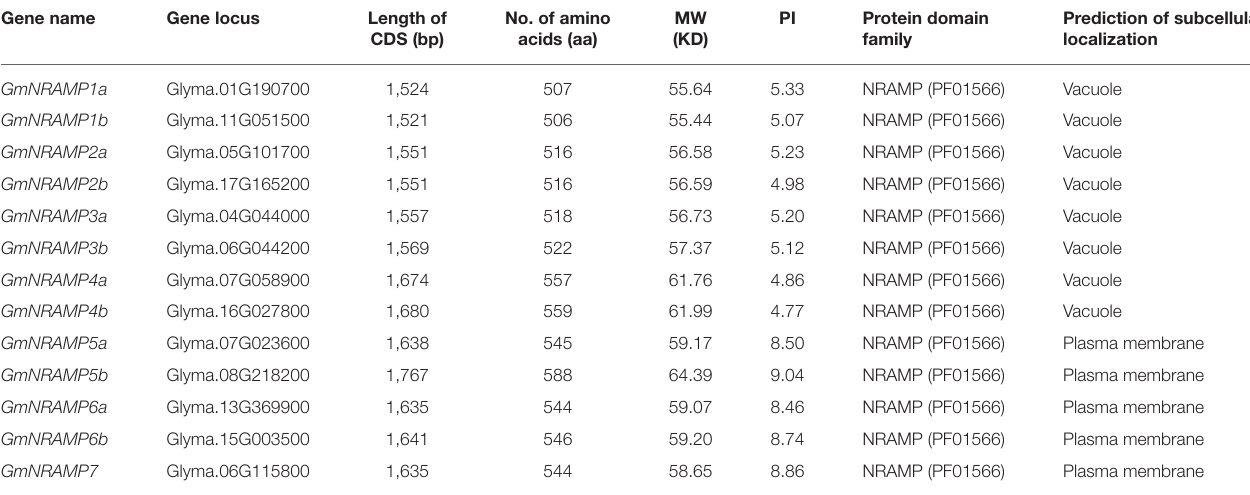
TABLE 1 | Summary of NRAMP family genes in